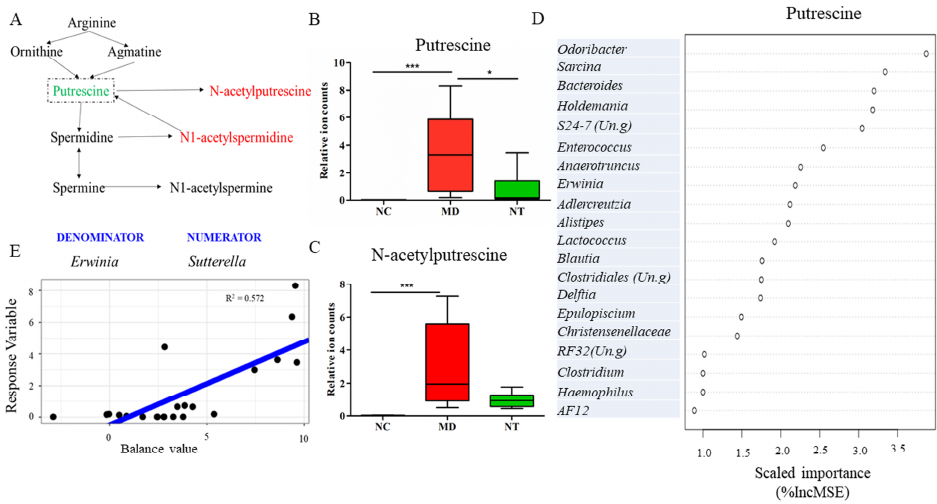
Figure 8. Microbial signatures correlated with gut luminal putrescine levels. ( A ) A diagram showing the arginine metabolism pathway. ( B ) The levels of putrescine and N-acetylputrescine ( C ) significantly impacted by neoagarotetraose (NT). ( D ) Microbial genera that were correlated with gut putrescine concentrations identified using a Random Forest regression model. E: A global balance or microbial signature strongly correlated with gut putrescine concentrations. NC: normal controls; MD: colitis induced by DSS; NT: DSS induced colitis mice supplemented with NT. %IncMSE: Percentage increase in mean squared error. * p < 0.05; *** p <